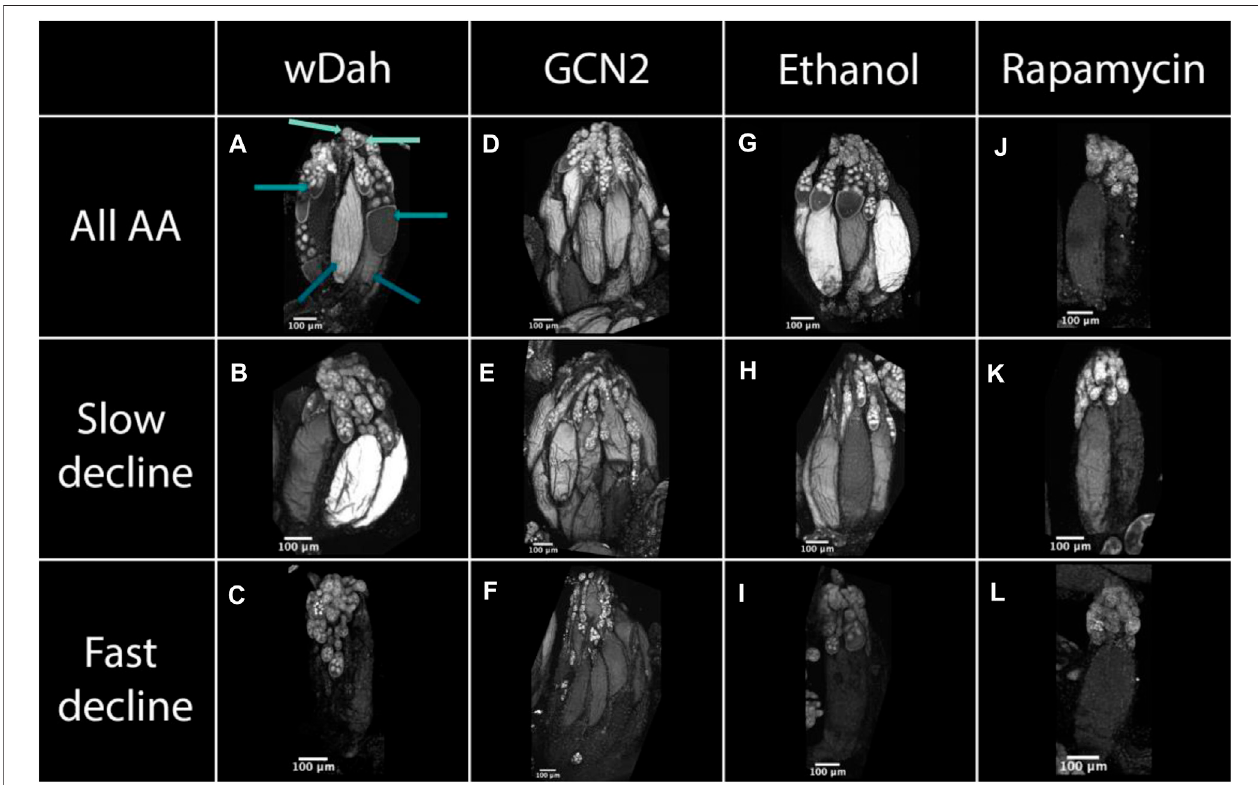
FIGURE 5 | Egg chamber development changes with diet and with reductions in GCN2 and TOR signalling. Ovaries from white Dahomey wDah, (A – C) , GNC2 mutant (D – F) , red Dahomey fed diets laced with ethanol Ethanol, (G – I) , and red Dahomey fed diets laced with rapamycin Rapamycin, (J – L) females. Females were fed eithera diet consisting ofall amino acids (All AA), (A,D,G,J) , diets thatinduced aslow decline inegg laying (nohistidine), (B,E,H,K) , or dietsthat induceda fast declinein egglaying(noarginine), (C,F,I,L) .AllsamplesarestainedwithDAPItovisualisenuclei.In (A) ,thelighttealarrowspointtoearly,thetealarrowspointtoyolk-forming, and the dark teal arrows point to late stage egg chambers. All pictures were taken after 7 days of diet exposure.